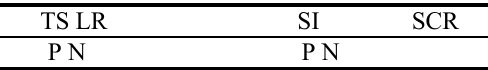
Table 1. Categories of selected indicators